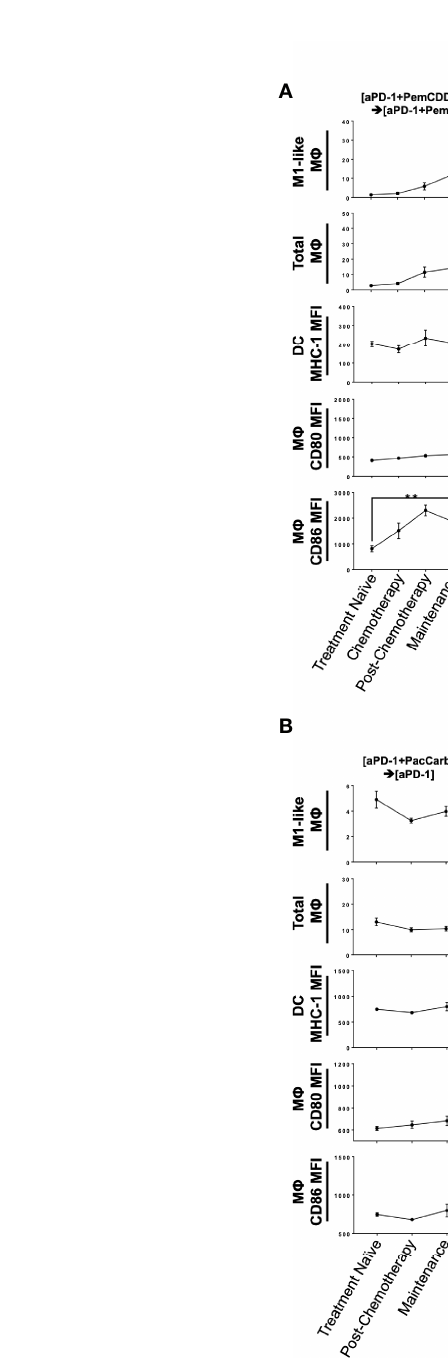
FIGURE 4 | Antigen-presenting machinery increases after SKI-G-801 treatment. Analysis of myeloid cell subset of TC1 tumor model (A) and C3PQ tumor (B) by fl ow cytometry. (A) M1-like macrophages were signi fi cantly increased in the maintenance state of the [aPD-1+PemCDDP] ! [aPD-1+Pem+SKI-G-801] group, the [aPD-1 +PemCDDP] ! [SKI-G-801] group, and the [aPD-1+PemCDDP+SKI-G-801] ! [aPD-1+Pem+SKI-G-801] group compared to the treatment naïve group. The macrophage total also increased in the maintenance state of the [aPD-1+PemCDDP] ! [SKI-G-801] group and the [aPD-1+PemCDDP+SKI-G-801] ! [aPD-1+Pem +SKI-G-801] group compared to the treatment naïve group. The number of CD86 expressing macrophages was signi fi cantly high in all groups compared to the treatment naïve group. (B) M1-like macrophages showed a decreasing trend in all groups, but total macrophage count was signi fi cantly increased in the maintenance state of the [aPD-1+PacCarb] ! [aPD-1+SKI-G-801] group compared to the treatment naïve group. In addition, the number of CD86 and CD80 expressing macrophages increased in the maintenance state of the [aPD-1+PacCarb] ! [aPD-1+SKI-G-801] group and the [aPD-1+PacCarb+SKI-G-801] ! [aPD-1+SKI-G-801] group compared to treatment naïve state. (*p ≤ 0.05, **p ≤ 0.01, ***p ≤